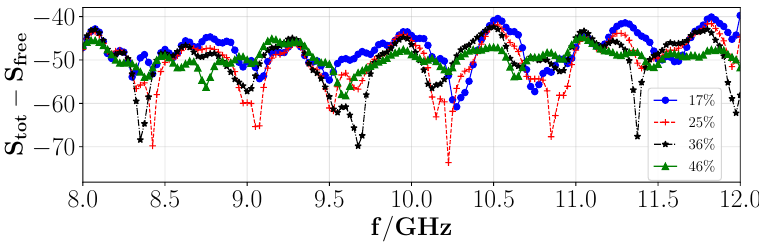
Figure 12. Experimental scattering response (in dB) in X-band of antenna 4 (middle antenna) for different moisture contents in the spherical wet spot of radius